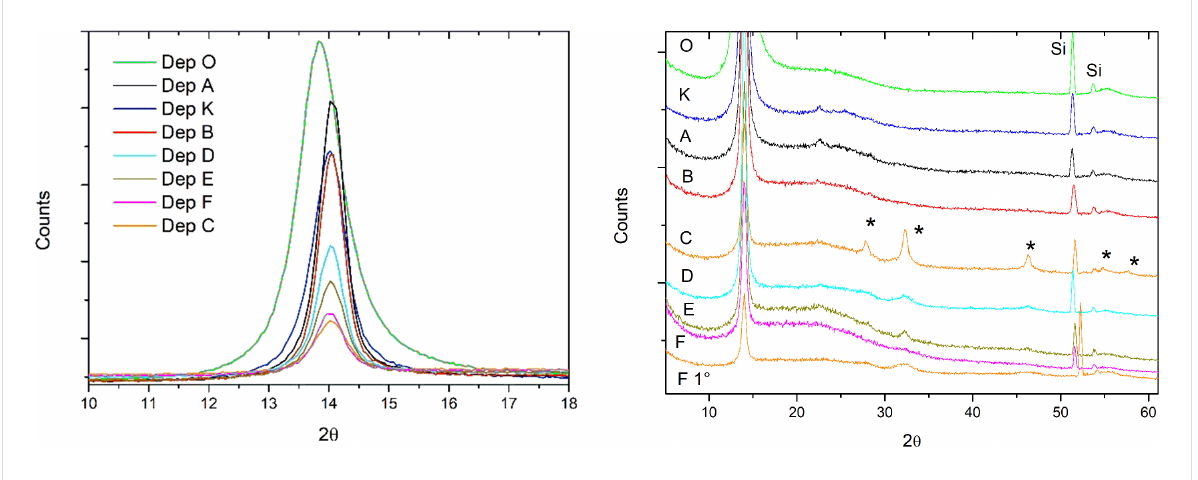
Figure 3: GIXRD spectra of pure and NCPC samples: left) the 2 θ region of the main parylene peak; right) the entire 2 θ range, which shows the effect of Ag incorporation on the structure of the films. The spectrum of sample F at 1° incidence angle is also shown. Asterisks indicate the peaks of Ag oxides. Si peaks coming from the substrate are also highlighted.